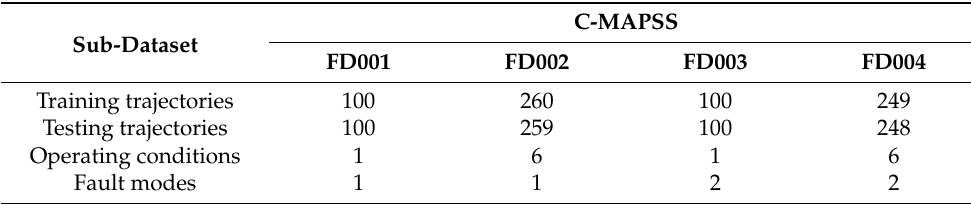
Table 1. Parameters of the